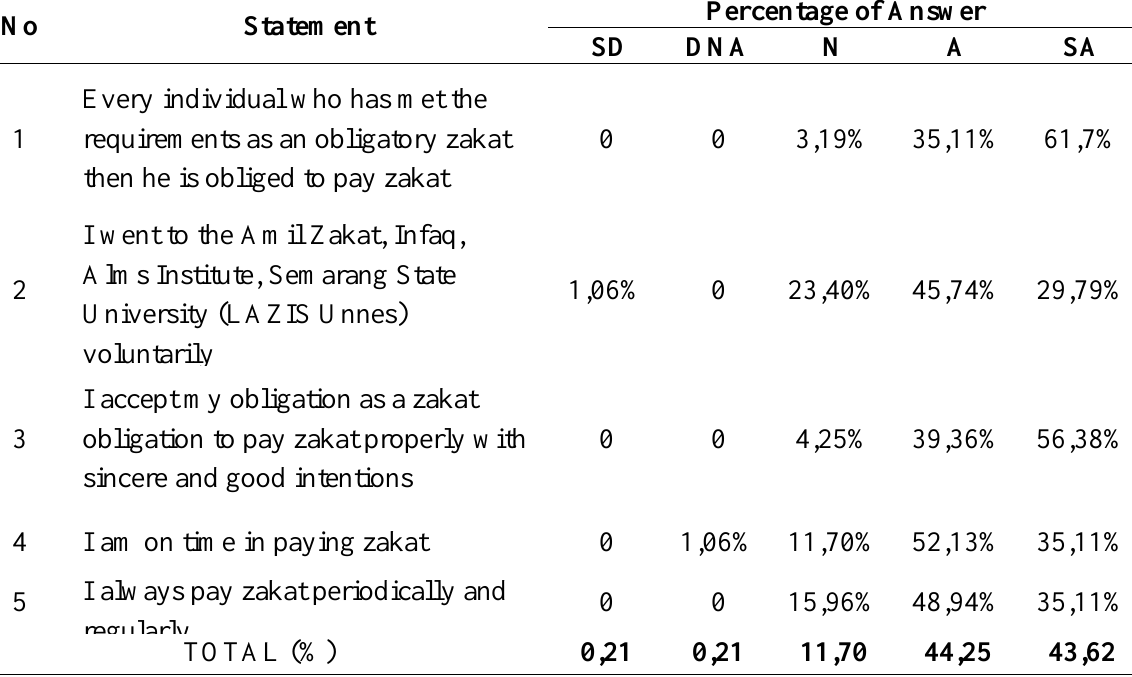
Table 7: Variable Description of Willingness to Pay